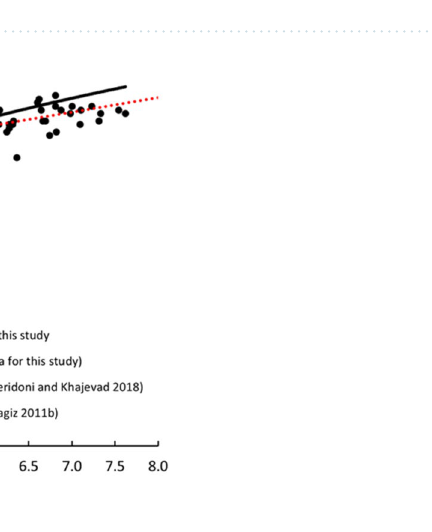
Figure 14. Comparison of results obtained in this study with those obtained in previous studies; V p versus PLI (I s(50) ) of limestone.